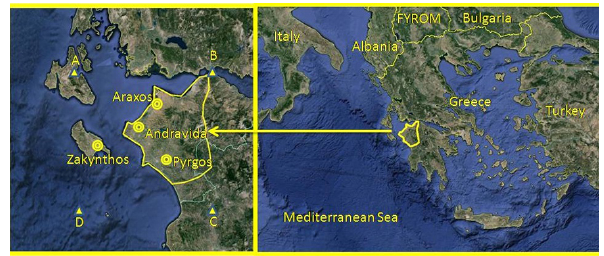
Figure 1. Map of examined area. The locations of the stations are displayed. The points A, B, C, D define the area of lightning